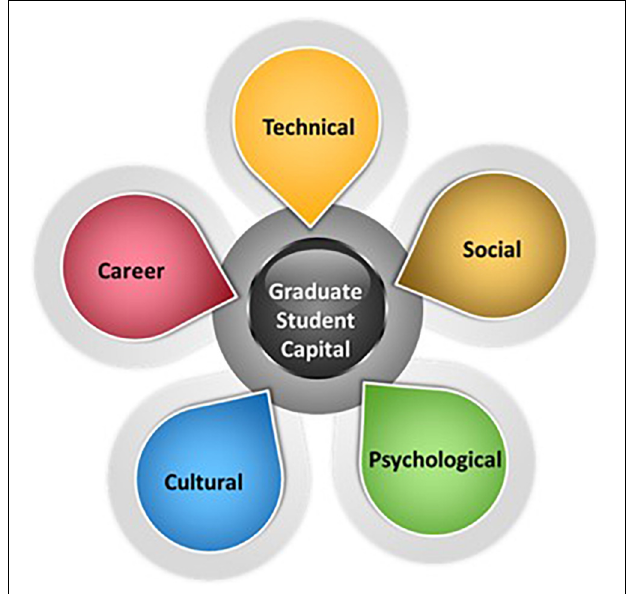
FIGURE 1 | Proposed variation of graduate student capital